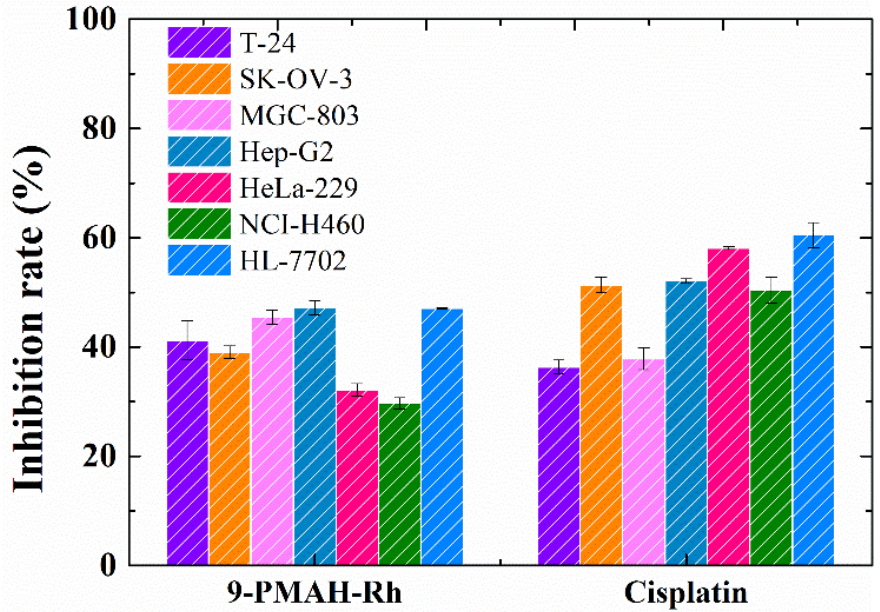
Figure 3. In vitro inhibition ratios (%) of 9-PMAH-Rh toward a series of human tumor cell